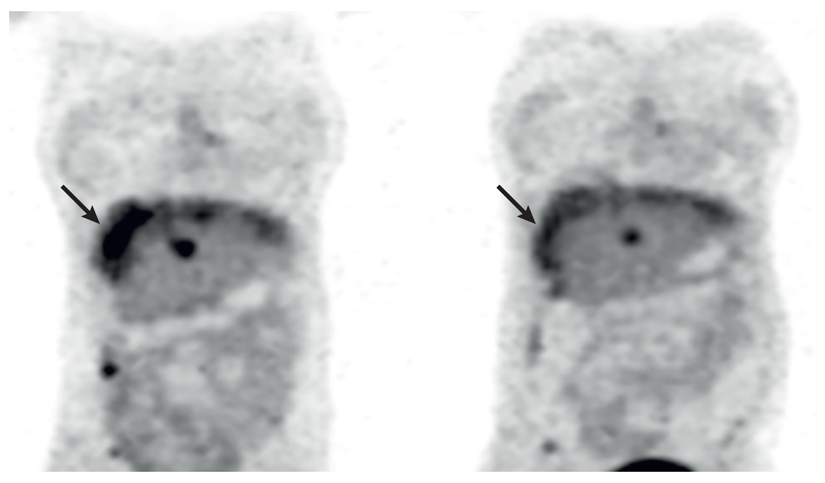
Clinical trial of the PI3K inhibitor pictilisib67 shows >30% reduction in the 18F-FDG-PET SUVmax in a patient with peri-hepatic disease from primary ovarian cancer before (left) and after (right) therapy. Adapted from Clin. Cancer Res., 2015, 21/1, Sarker, D. et al. First-in-human phase I study of pictilisib (GDC0941), a potent pan–class I phosphatidylinositol-3-kinase (PI3K) inhibitor, in patients with advanced solid tumors, with permission from AACR.